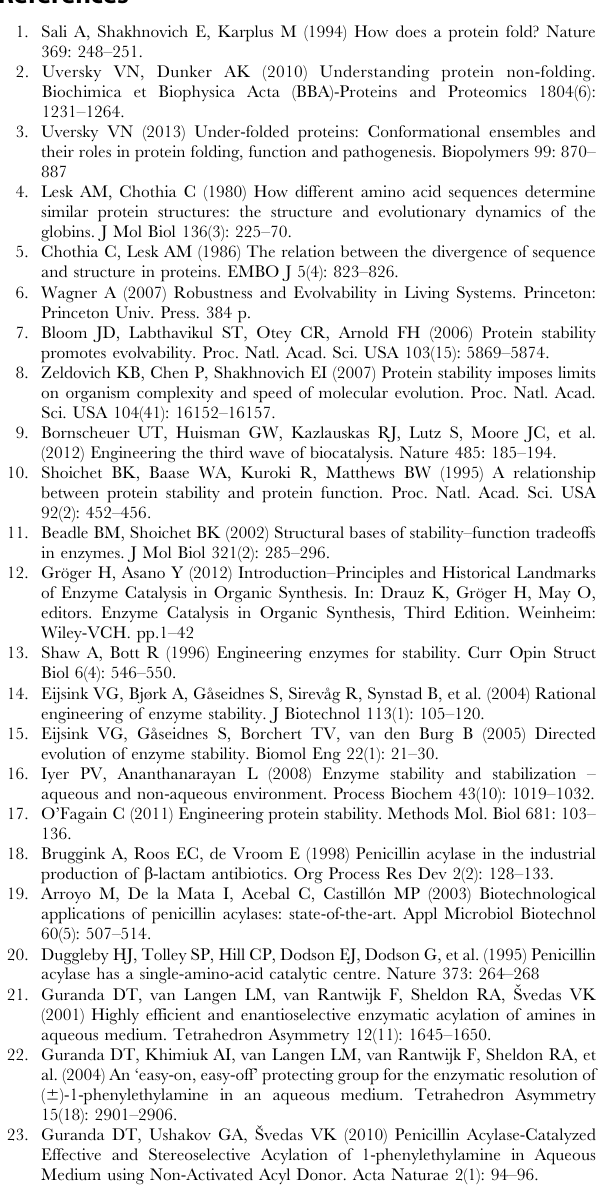
Figure S4 Secondary structure as a function of time, for D b 484N mutant of Ec PA at pH 7.5 . The plot is based on a single representative MD, selected from three independent MD runs for the given protein at given conditions. Residue numbers are given in an absolute order. Dashed line separates chains a and b , consisting of 209 and 557 amino acid residues, respectively. Residues b 482 and b 484 are indicated by a red arrow. (TIF) Figure S5 Secondary structure as a function of time, for D b 484N mutant of Ec PA at pH 10.0 . The plot is based on a single representative MD, selected from three independent MD runs for the given protein at given conditions. Residue numbers are given in an absolute order. Dashed line separates chains a and b , consisting of 209 and 557 amino acid residues, respectively. Residues b 482 and b 484 are indicated by a red arrow. (TIF)